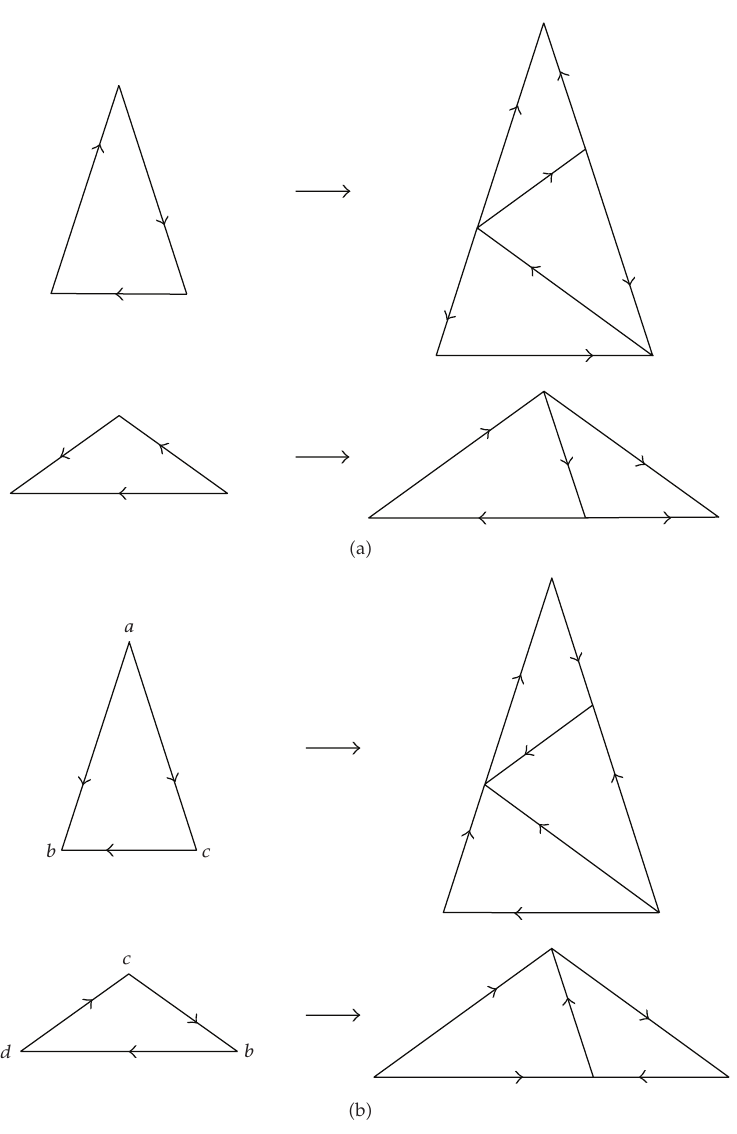
Figure 2: Arrowed prototiles and inflation rules of (cid:6) a (cid:7) T − and (cid:6) b (cid:7) Penrose